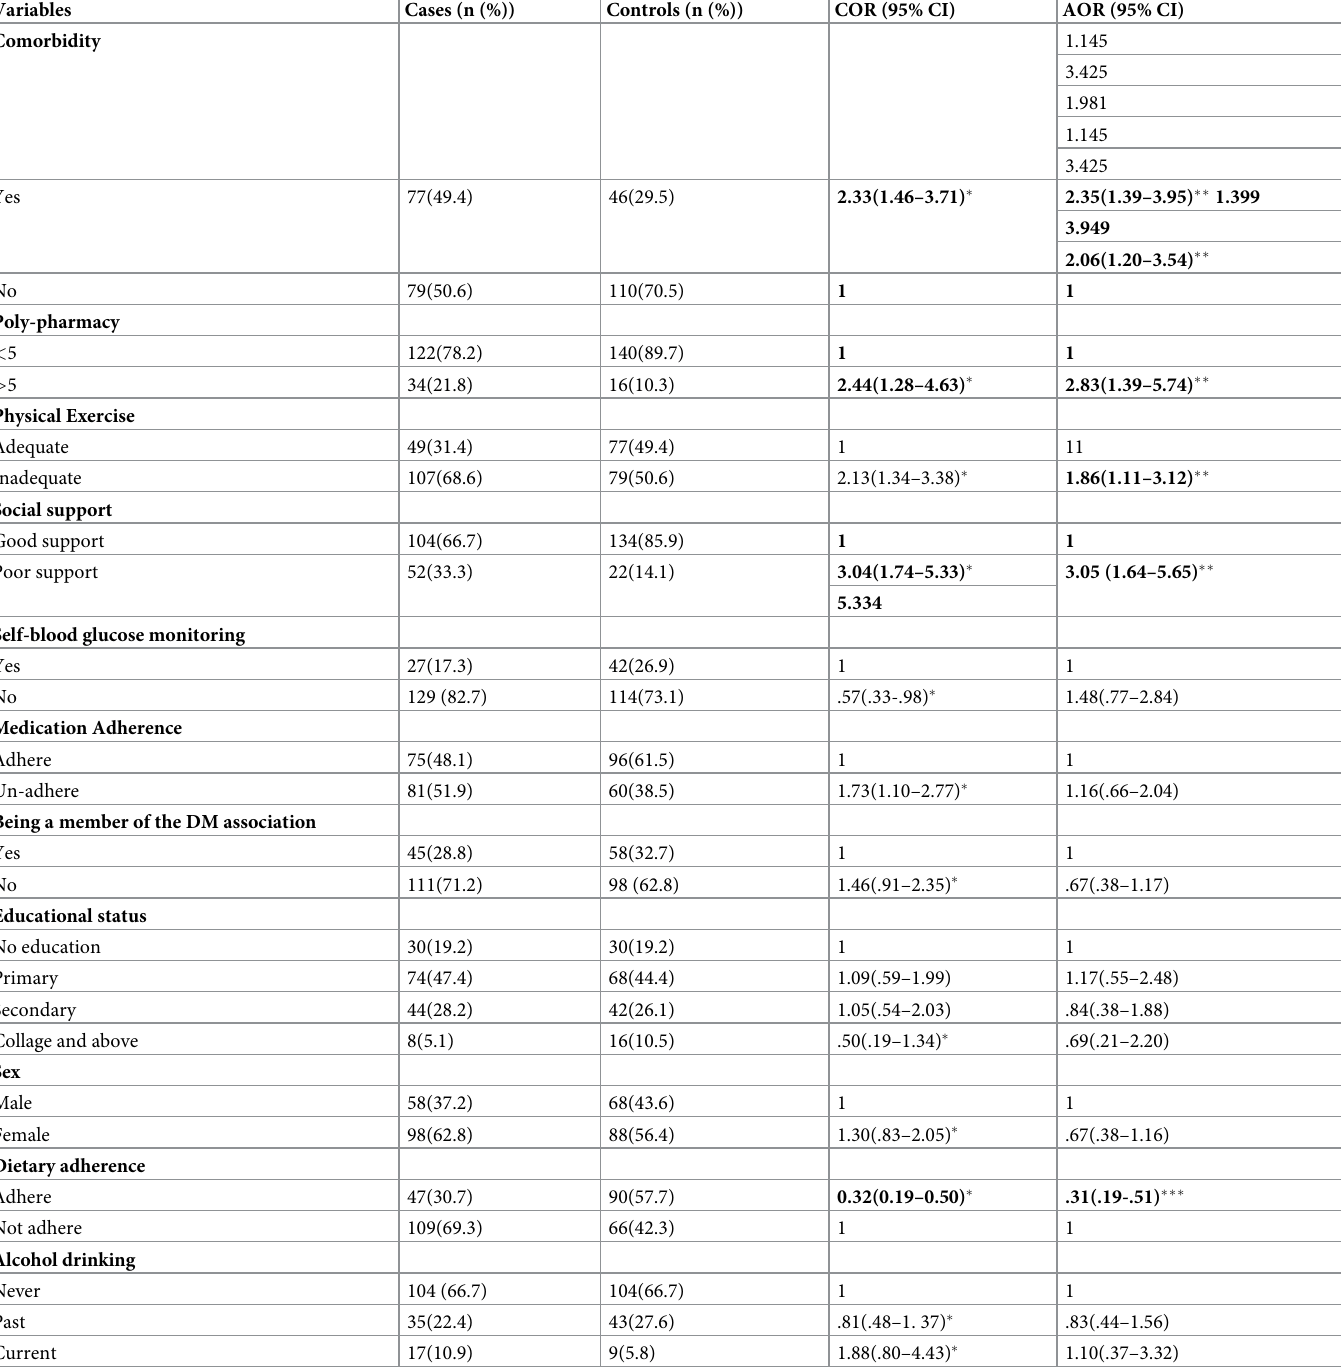
Table 4. Bivariate and multivariate logistic regression of factors associated with poor glycemic control among type 2 diabetic patients under follow-up clinics at Gamo and Gofa zones, Southern, Ethiopia,